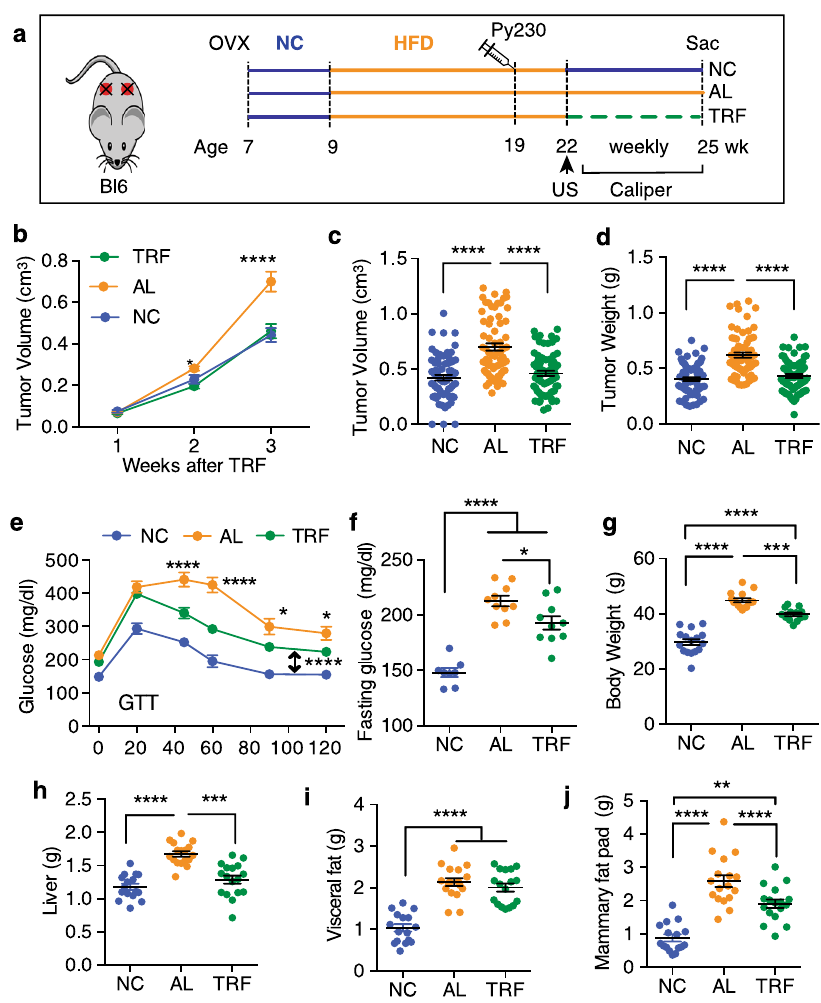
Fig. 5 TRF inhibited growth of pre-existing Py230 mammary tumors in obese postmenopausal mouse model. a Schematic showing experimental design with Py230 breast tumor injection 3 weeks prior to initiation of TRF. OVX mice are placed on HFD for 10 weeks to become obese then injected with py230 cells in the mammary fat pad. Three weeks after tumor cells injection the tumors were measure by ultrasonography imaging system (US) to con fi rm tumor development and randomized into AL or TRF HFD groups or NC group for a further 3 weeks and tumor size was measured weekly with calipers. b Py230 tumor volume over time following TRF (number of mice n = 17, * p < 0.05, **** p < 0.0001 by two-way ANOVA with Tukey ’ s multiple comparisons test). c , d Tumor volume and weight at the end of the study (number of tumors n = 67 for NC, n = 86 for AL and TRF, **** p < 0.0001 by two-way ANOVA with Tukey ’ s multiple comparisons test, n represents number of tumor). e Intraperitoneal-glucose tolerance test (GTT) after 3weeks of TRF (number of mice n = 8 for NC, n = 10 each for AL and TRF, * p < 0.05, **** p < 0.0001 by two-way ANOVA with Tukey ’ s multiple comparisons test). f Fasting blood glucose at end of study (number of mice n = 8 for NC, n = 10 each for AL and TRF, * p < 0.05, **** p < 0.0001 by 1-way ANOVA with Tukey ’ s multiple comparisons test). g Bodyweight at end of study (number of mice n = 16 for NC, n = 15 for AL, n = 13 for TRF, *** p < 0.001, **** p < 0.0001 by one-way ANOVA with Tukey ’ s multiple comparisons test). h – j Liver tissue, visceral fat, and mammary fat weight at end of study (number of mice n = 16 for NC, n = 17 for AL, n